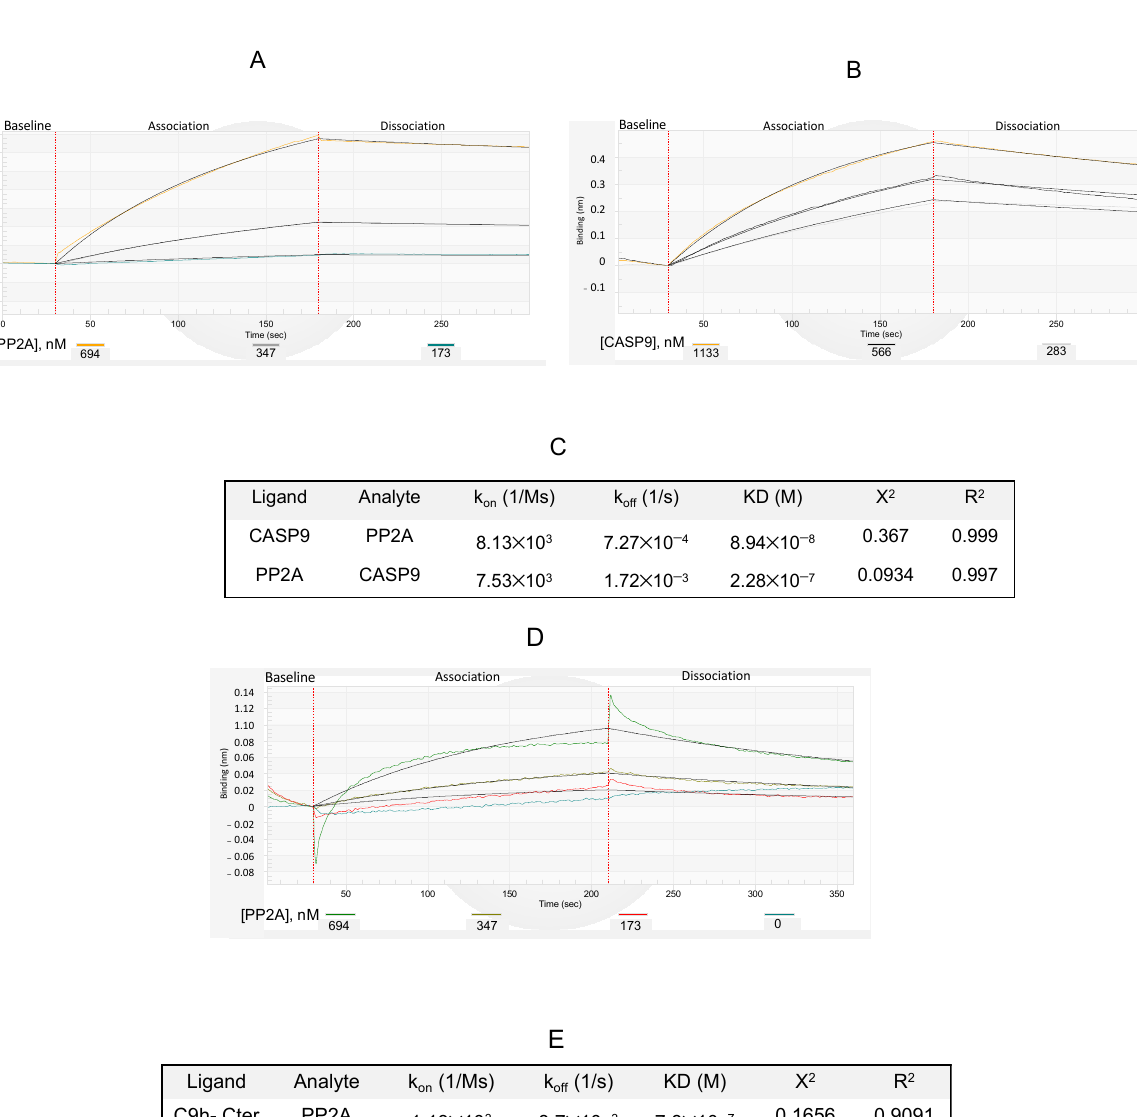
Figure 6. Blitz sensorgrams of PP2A/Caspase 9 interaction. The biolayer interferometry (BLI) signal is given in relative intensity units (nm): ( A ) Caspase 9 ligand was immobilized at 566 nM onto a Protein A biosensor previously coated with a mouse anti-Caspase 9 monoclonal antibody. The association and dissociation steps of the PP2A analyte injected at concentrations of 649, 347, and 173 nM were shown. ( B ) PP2A ligand was immobilized at 694 nM onto a Protein A biosensor previously coated with a rabbit anti-PP2A polyclonal antibody. Association and dissociation of the Caspase 9 analyte loaded at 694, 347, and 173 nM were shown. ( C ) Binding rate constants and apparent affinities of PP2A/Caspase 9 interactions in BLI were calculated with BLItz Pro Software. ( D ) PP2A was used at 463, 556, and 694 nM as indicated, and sample diluent (PP2A, 0 nM) was designed as sample for reference subtraction. Unspecific binding of PP2A to the sensor tip in absence of peptide was checked using PP2A at the same concentrations. ( E ) Binding rate constants and affinities of C9h-Cter peptide and PP2A were calculated with BLItz Pro Software.